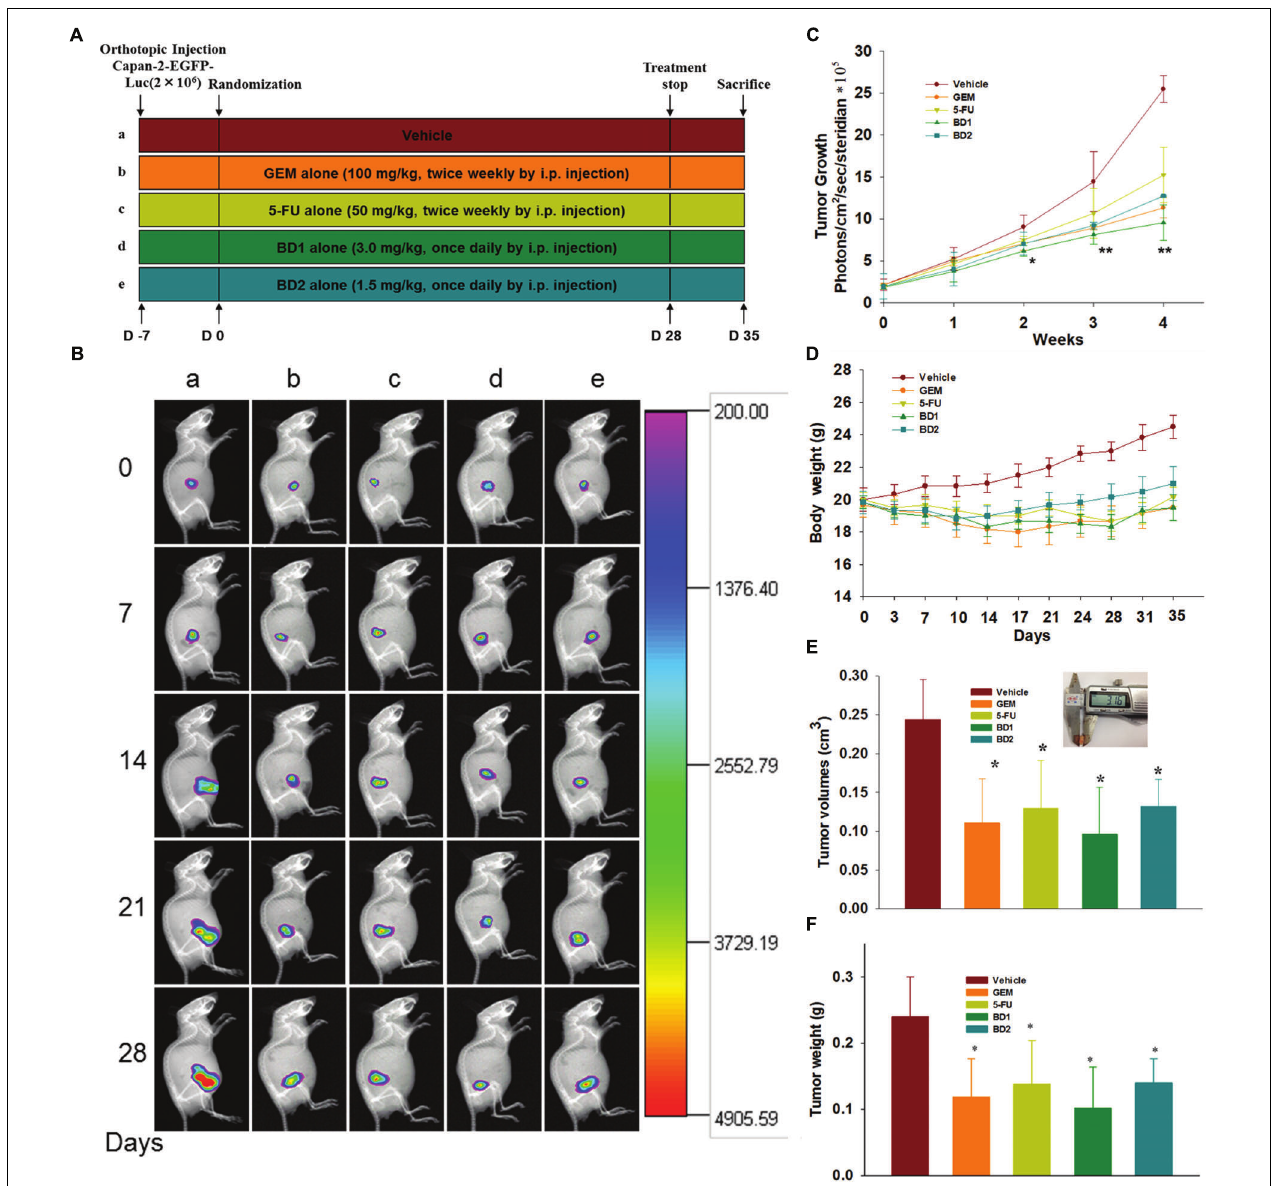
FIGURE 6 | BD inhibits the tumor progression in orthotopic xenograft mouse model. (A) Schematic depiction of the experimental schedule as presented in section “Materials and Methods” ( n = 8). (B) Bioluminescence In-Vivo FX PRO images of orthotopically implanted Capan-2 cells in live, anesthetized mice under different treatment regimens every week. (C) Determination of photons per second showing the tumor volume at different time points by live bioluminescence imaging. (D) Body weight alternations of mice were determined at the indicated time. (E) Tumor volumes in mice were determined at autopsy with vernier calipers and calculated following the formula V = 4/3 π (a/2 ∗ b/2 ∗ c/2) ( n = 8). (F) Average tumor weight of each group on the last day of the experiment. Each column represents the mean ± SD of eight samples. ∗ P < 0.05 and ∗∗ P < 0.01 vs. the control